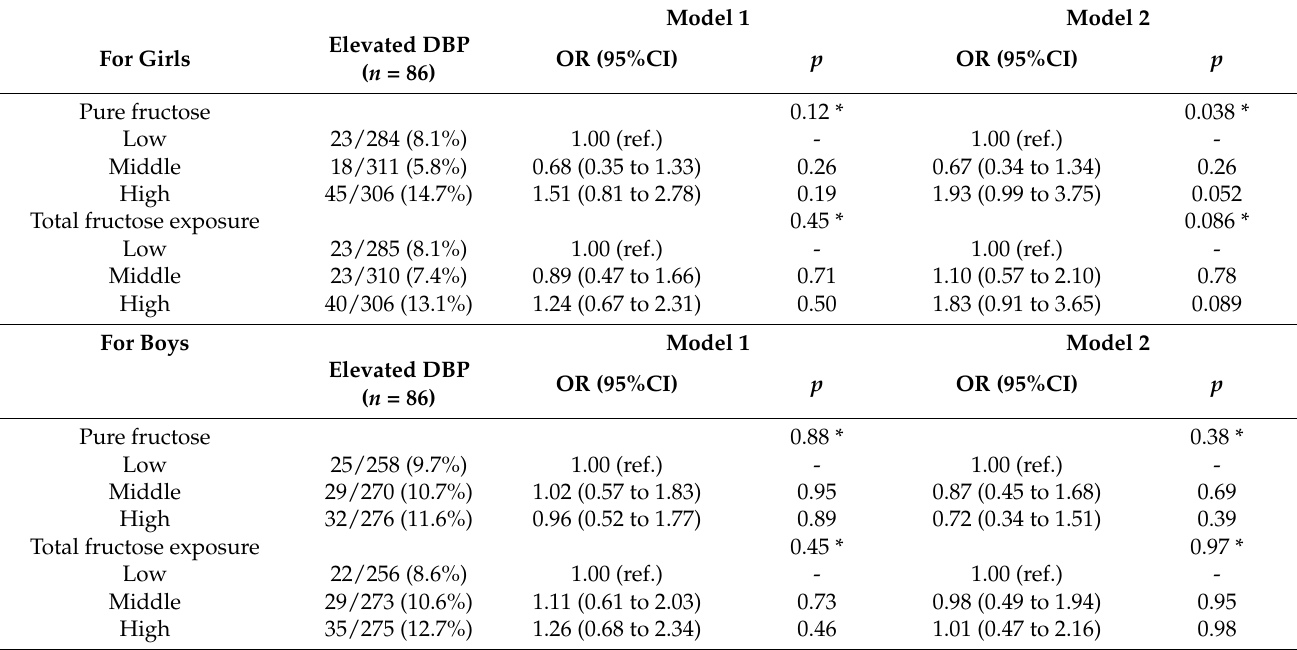
Table 5. Association between elevated diastolic blood pressure and pure and total fructose exposure from various fructose- containing